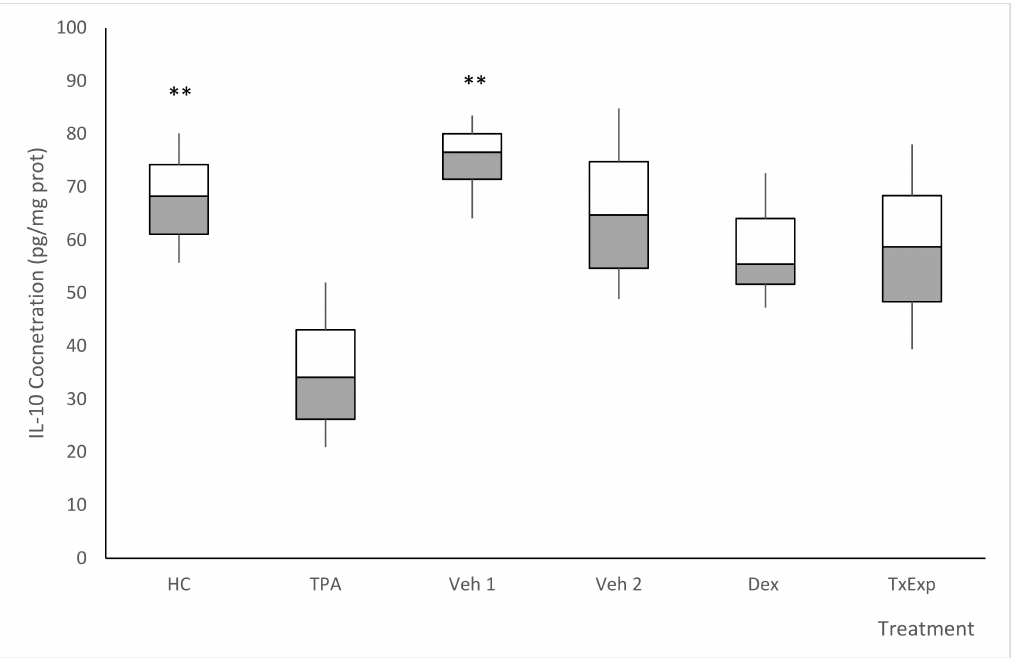
Figure 10. Tissue concentration of interleukin 10. Treatment groups correspond to mice without any treatment (HC). The negative control group was administered with TPA. The Veh1 and Veh2 control groups correspond to the TPA dissolution vehicle (acetone) and the treatment dissolution vehicle (cyclodextrin and Tween 20). S. dendroideum extract is the experimental treatment. Post hoc Tukey ANOVA n = 6, (**) p < 0.05, with respect to the negative control